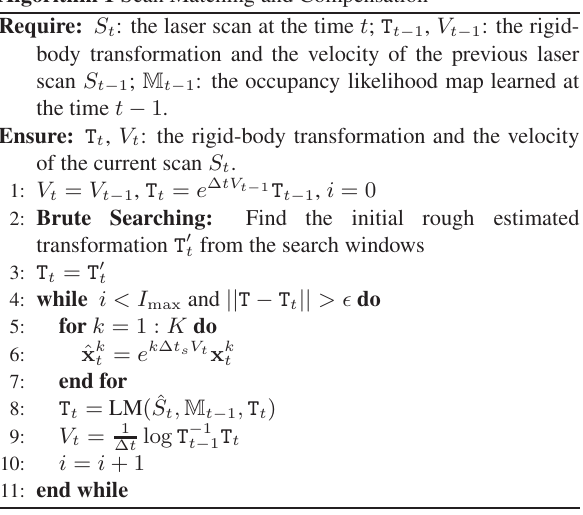
Algorithm 1 Scan Matching and